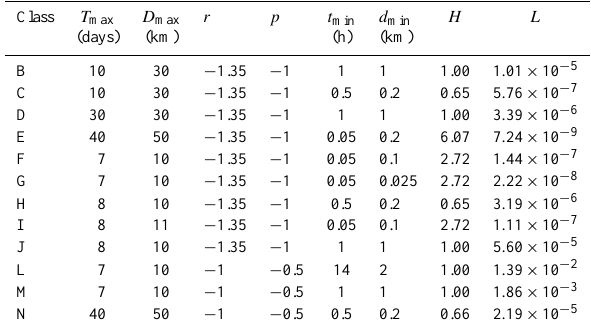
Table 1. All classes. T max is the maximum time interval between events, D max is the maximum distance between events, r is the ex- ponent of the distance weight w d (Eq. 1), p is the exponent of the time weight w t (Eq. 2), d min and t min represent cutoff values, H is the highest value of the total edge weight in the class, and L is the lowest value of the total edge weight in the